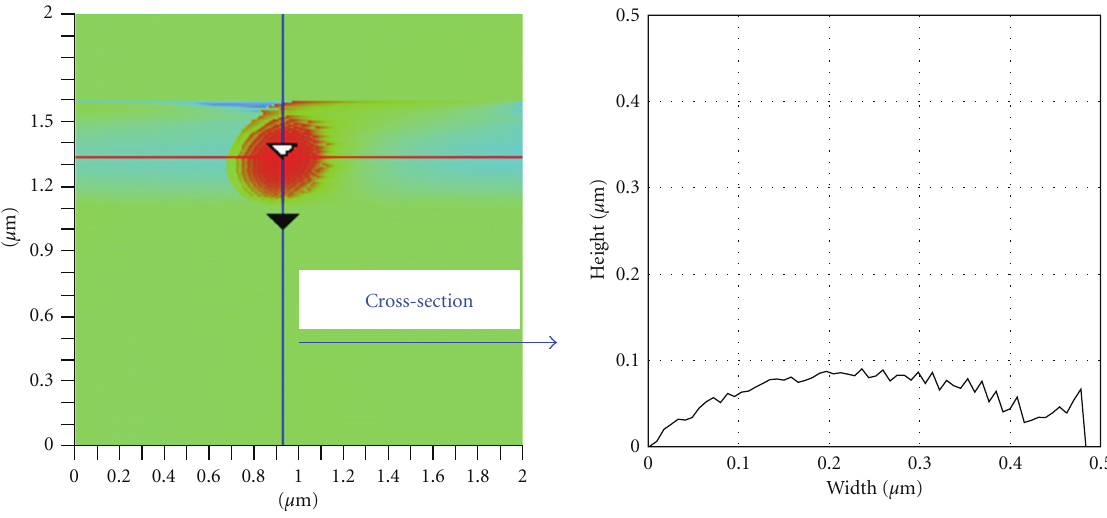
Figure 5: The droplet observation on the media by AFM.